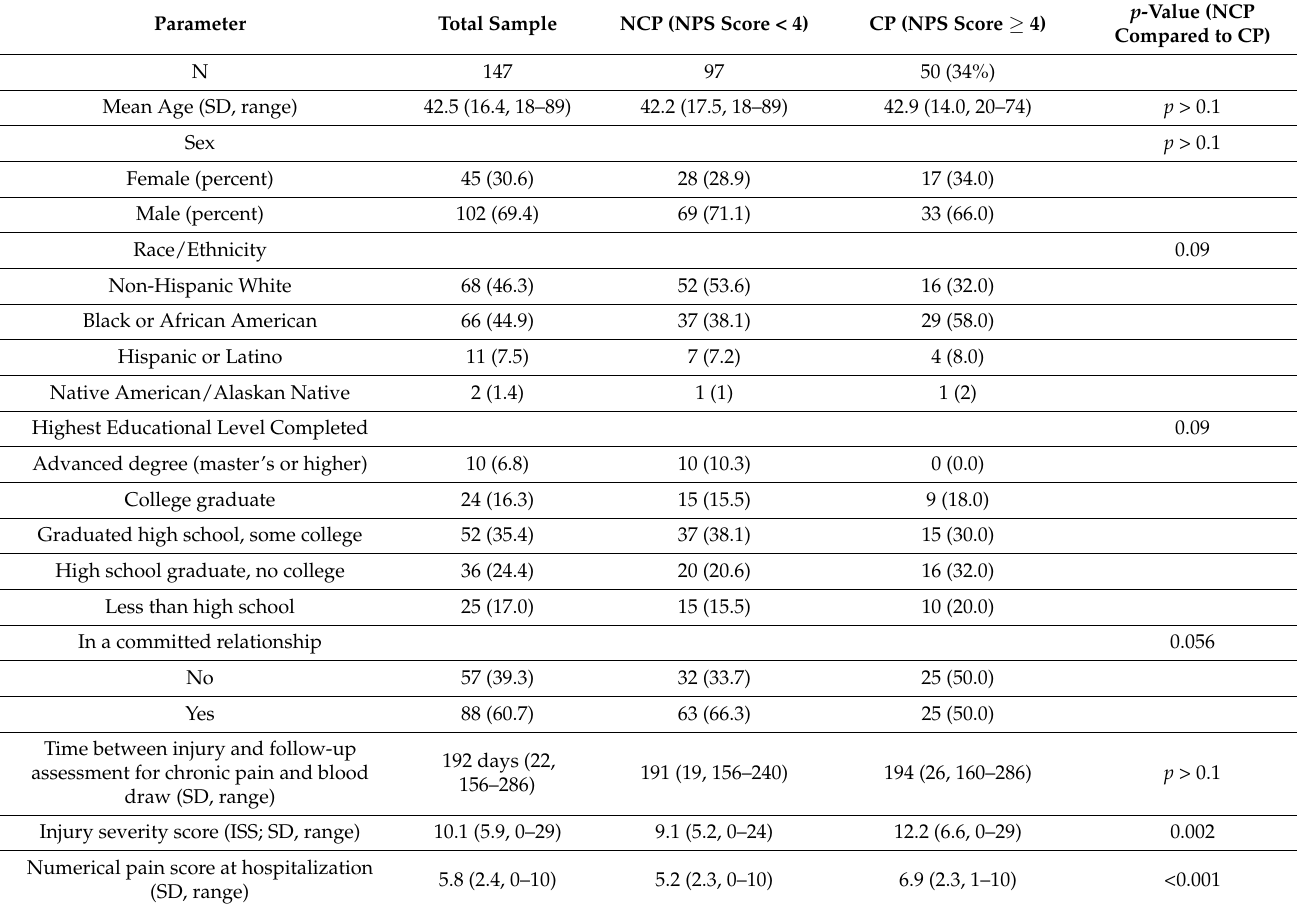
Table 2. Demographic and clinical data of the study